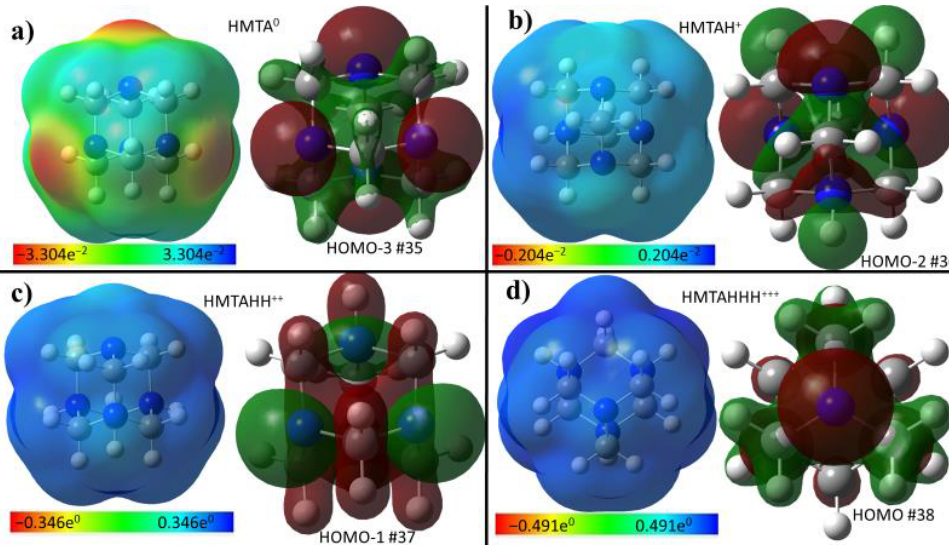
Figure 7 . Electrostatic potential surface (ESP) and the molecular orbitals of HMTA in its neutral form ( a ), monoprotonated ( b ), bi protonated ( c ), and tri protonated ( d ).